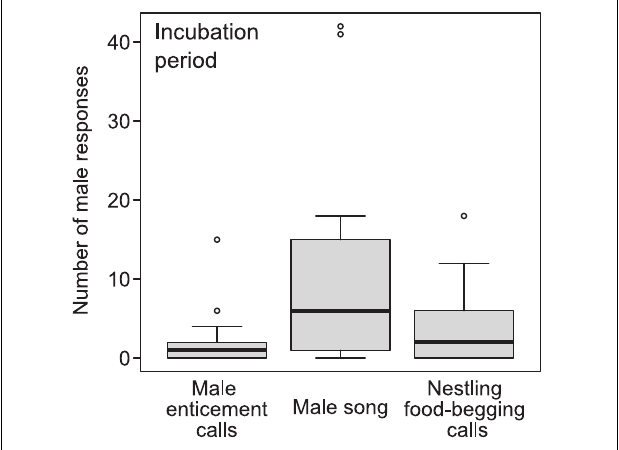
FIGURE 1 | Boxplot of the number of male responses to each type of vocalisation during the playback experiment during the incubation period. The bar in each boxplot indicates the median value, and the box shows the first and third quartiles of data. The whiskers range from the lowest to the highest data points within 1.5 × the interquartile range of the lower and upper quartiles, respectively. Data points beyond the range of the whiskers are outliers and are depicted by circles. Each call was broadcast in a random